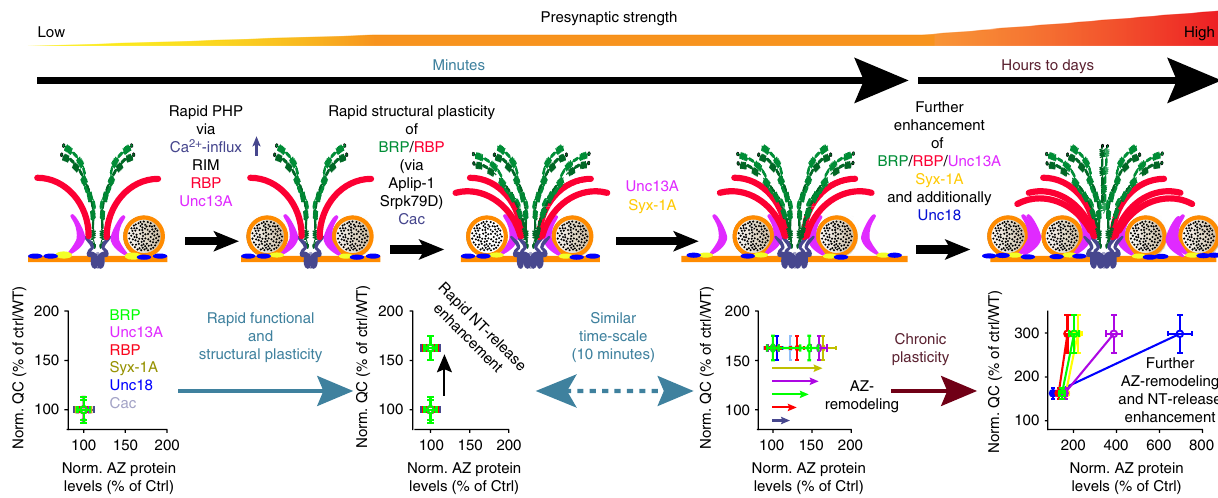
Fig. 8 Sequence of events enabling rapid and sustained homeostatic plasticity Top row: Illustration of AZ modes addressed. Bottom row: Plot of normalized quantal content (QC) vs. AZ protein levels of experiments performed in Fig. 1 normalized to either Ctrl ( − PhTx) for rapid plasticity or wild-type for chronic plasticity. In the basal activity mode (left), BRP (green), RBP (red), Syx-1A (yellow), Unc18 (blue) and Unc13A (magenta) provide two SV release sites at the Ca 2 + -channel (Cac; light blue). However just one release site is active (occupied by SV). (Second left) During the rapid functional plasticity phase the quantal content (and thus neurotransmitter (NT) release) is rapidly enhanced within minutes via mechanisms involving altered Ca 2 + -in fl ux as well as RIM, RBP and Unc13A. On a comparable time-scale (minutes), BRP and RBP are incorporated in a pre-existing AZ in an Aplip-1/Srpk79D dependent manner and additionally Cac-levels also increase (third cartoon). The BRP/RBP incorporation enhances AZ levels of Unc13A/Syx-1A providing an additional release sites (fourth left). This rapid structural AZ-remodeling is not required for the rapid functional plasticity but directly acts on the consolidation of the release enhancement. (Right) On longer time-scales, chronic plasticity then further enhances the AZ-levels of BRP, RBP, Syx-1A in a conserved stoichiometry, while Unc13A and Unc18 increase out of scale, increasing the number of release sites and thus transmitter release/quantal content activity even